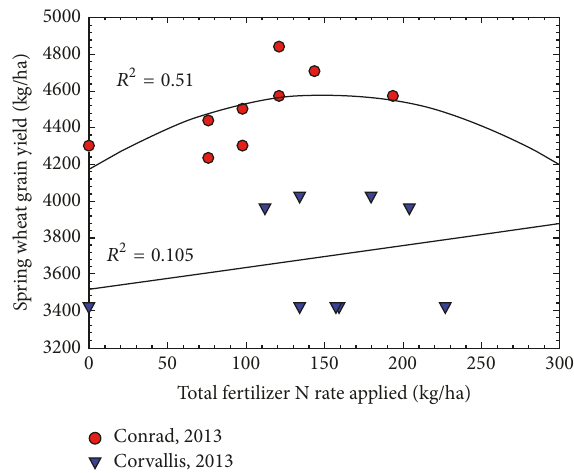
Figure 2: Spring wheat grain yield as affected by total amount of applied N fertilizer, Conrad and Corvallis, MT, 2011.